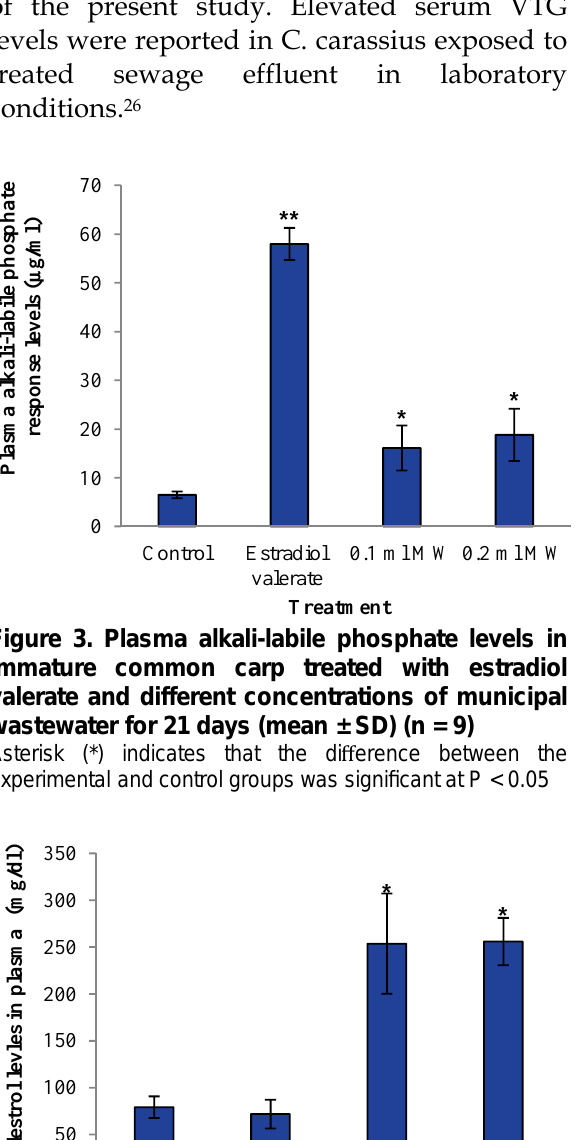
* Figure 5. Plasma triglyceride levels in immature Figure 4. Plasma cholesterol levels in immature common carp treated with estradiol valerate and common carp treated with estradiol valerate and different concentrations of municipal different concentrations of municipal wastewater for 21 days (mean ± SD) (n = 9) wastewater for 21 days (mean ± SD) (n = 9) Asterisk (*) indicates that the di ff erence between the Asterisk (*) indicates that the di ff erence between the experimental and control groups was significant at P < 0.05 experimental and control groups was significant at P < 0.05